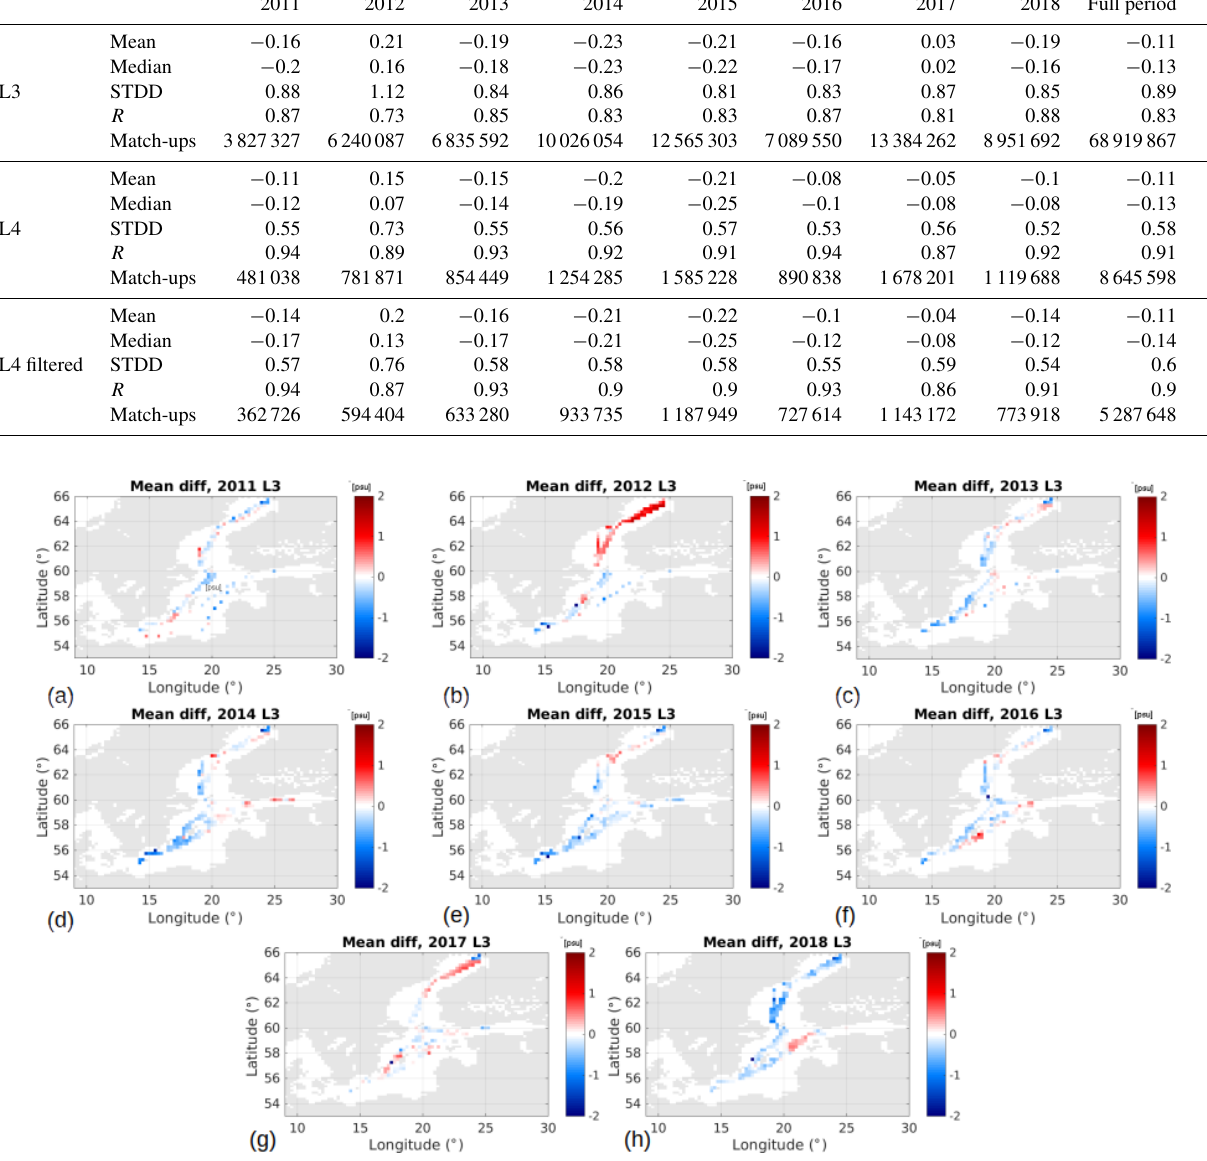
Figure 14. Comparison of L3 SSS and ferry data: spatial distribution of the mean of (cid:49) SSS [psu] per year (from a 2011 to h 2018). The reason behind the positive biases for years 2012 and 2017 in the Gulf of Bothnian is under